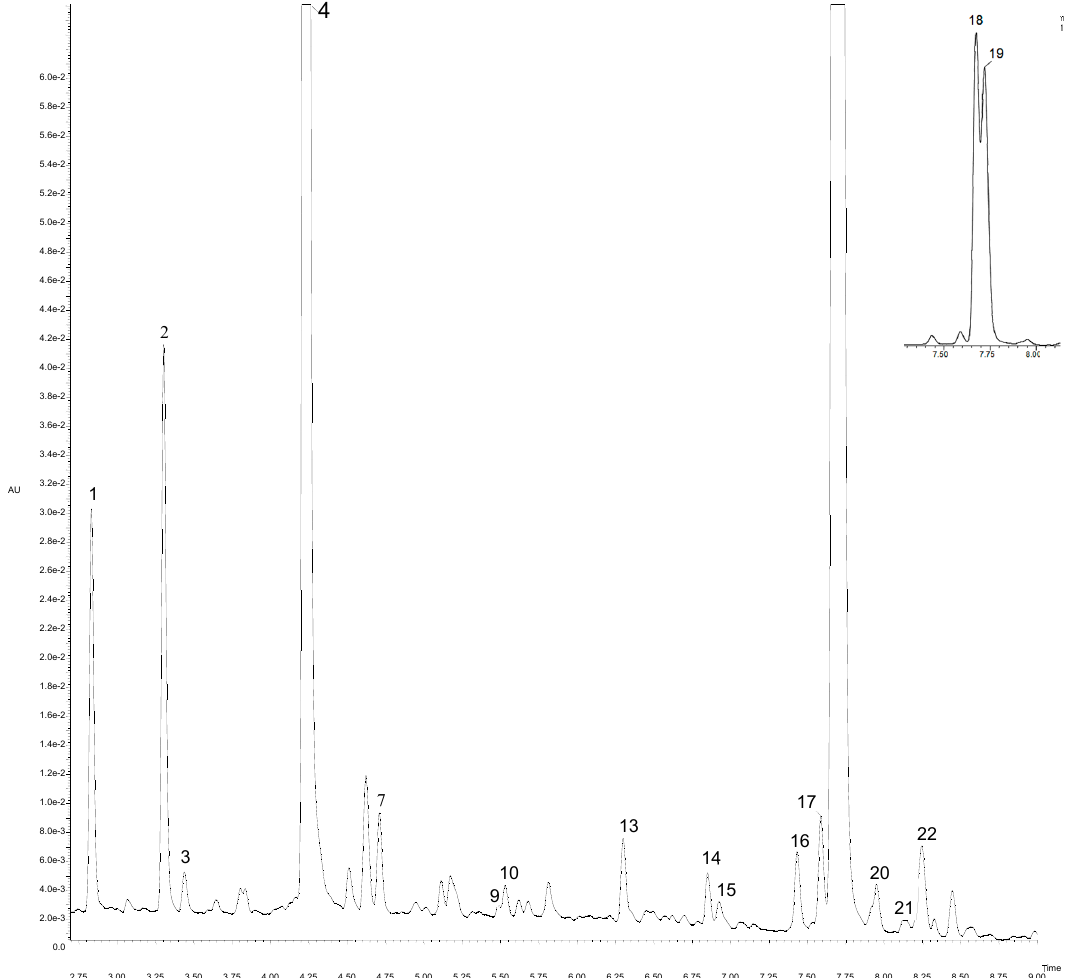
Figure 2. UPLC-PDA chromatogram at 320 nm of artichoke “Calico” cv. Peak number identities are displayed in Table 3.